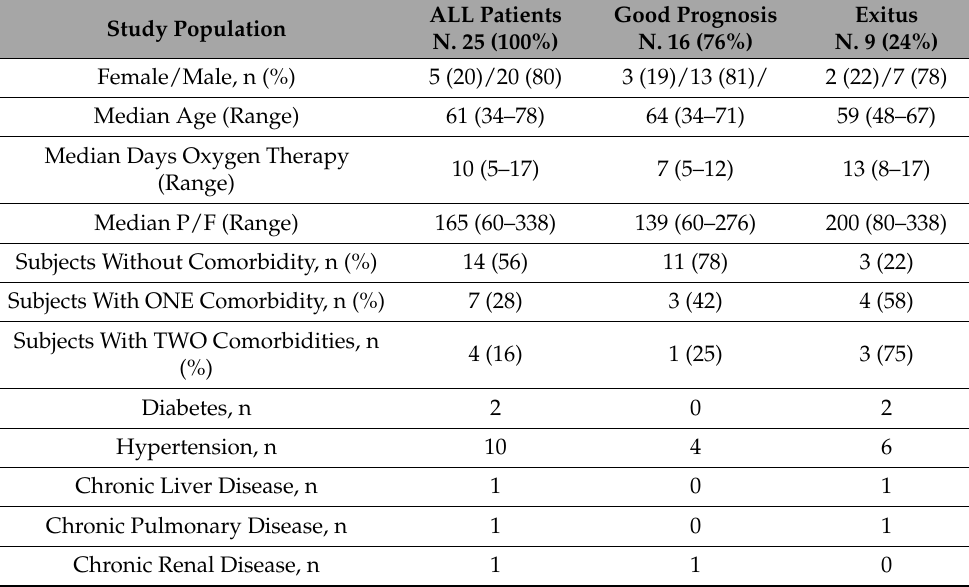
Table 1. Patient demographics. For this study, a total of twenty-five patients diagnosed with SARS- COV-2 infection were enrolled and classified into two group on the basis of their outcome: the Exitus Group (patients who died while still positive to Covid-19) and the Good Prognosis Group (patients recovered from Covid-19 and who are still